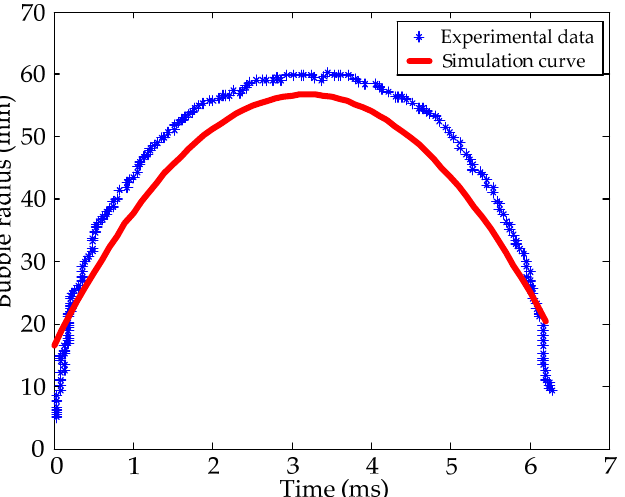
Figure 23. The relationship between the horizontal direction diameter of the bubble’s first pulse cycle and time when γ = 0.33 and ζ = 1.2. The blue line is the experimental measurement result. The red line is the ABAQUS/Explicit simulation result.